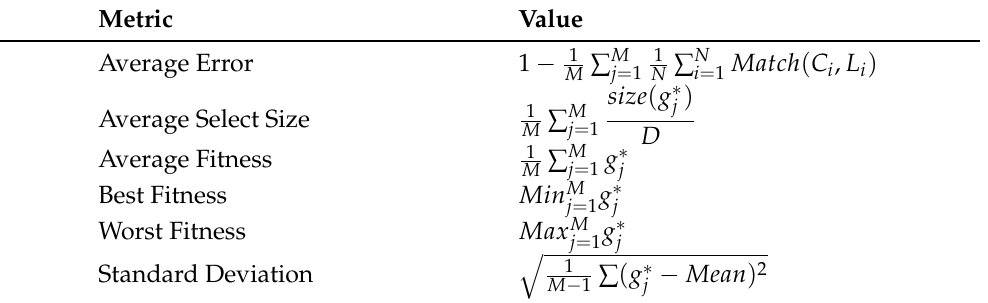
Table 5. Feature selection performance metrics.